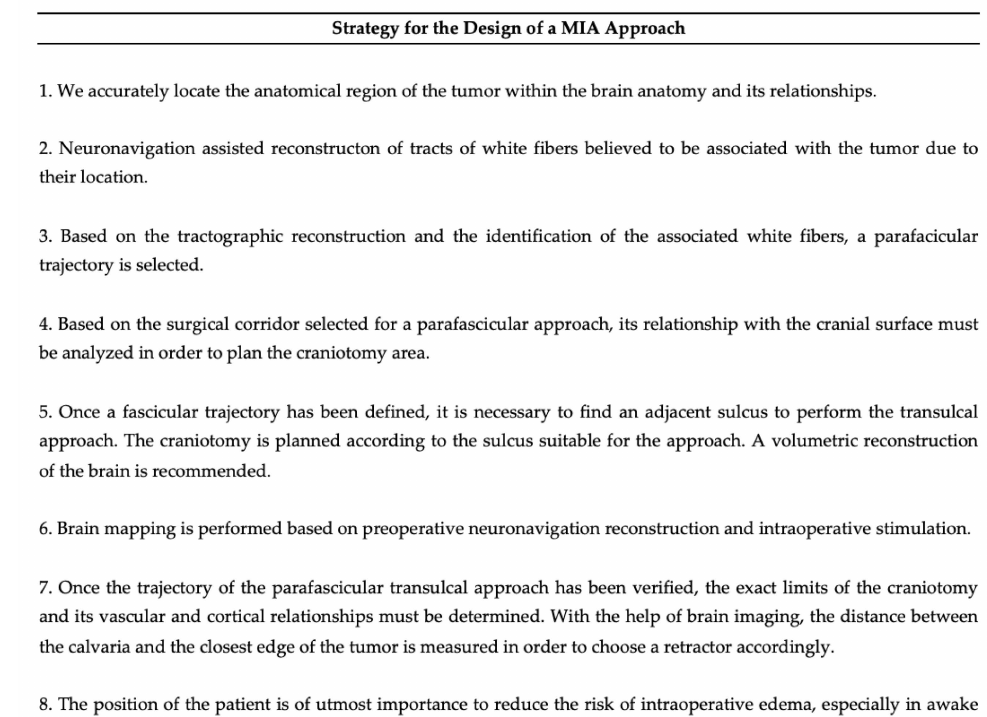
Figure 1. The Eight Step Strategy for PTA